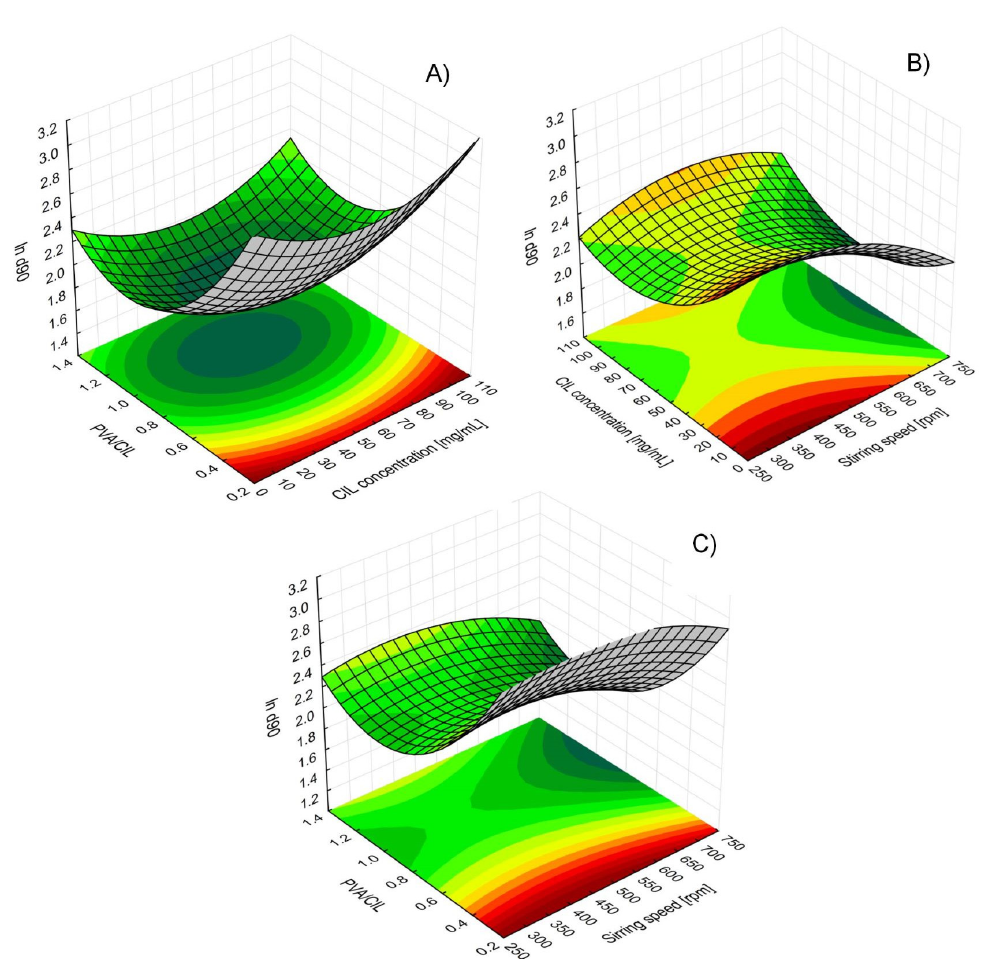
Figure 4. Response surface maps (RSM) for LASP with ln d90 as response variable. ( A ) PVA/CIL vs. CIL concentration at stirring = 750 rpm; ( B ) CIL concentration vs. stirring speed at PVA/CIL = 0.75; ( C ) PVA/CIL vs. stirring speed at CIL concentration = 55 mg/mL. Red colored areas correspond to the settings where highest values of ln d90 are achieved, while green color with increasing intensity - to the lowest values.